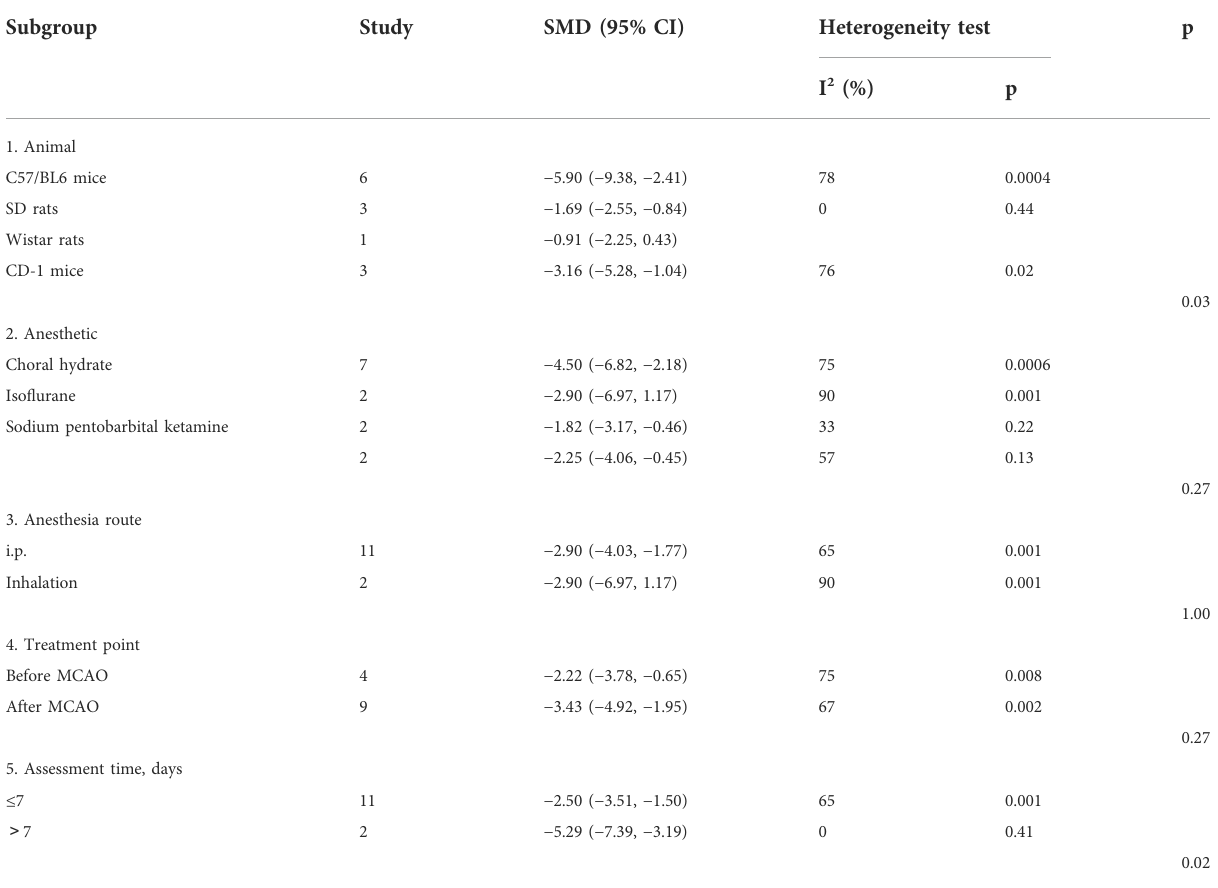
TABLE 5 Strati fi ed meta-analysis of the infarct